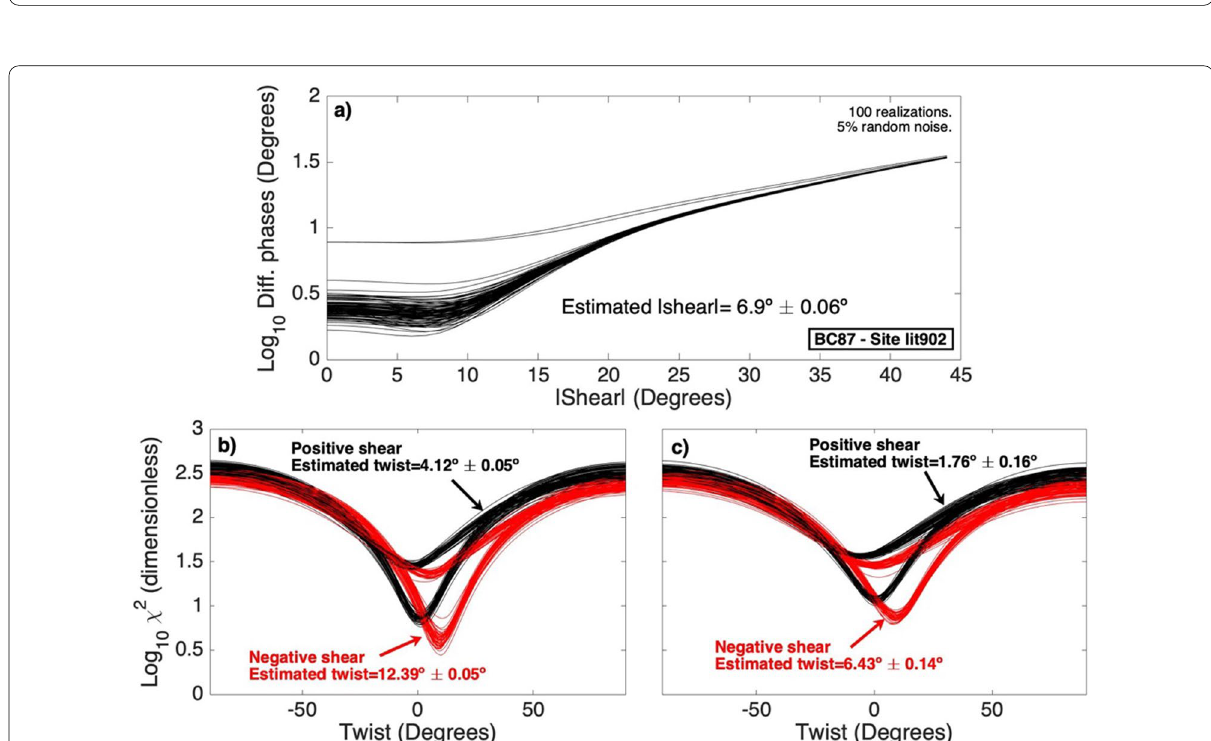
Fig. 13 The contours represent the misfit to the data: a strike of 61.87º and Z more significant misfit